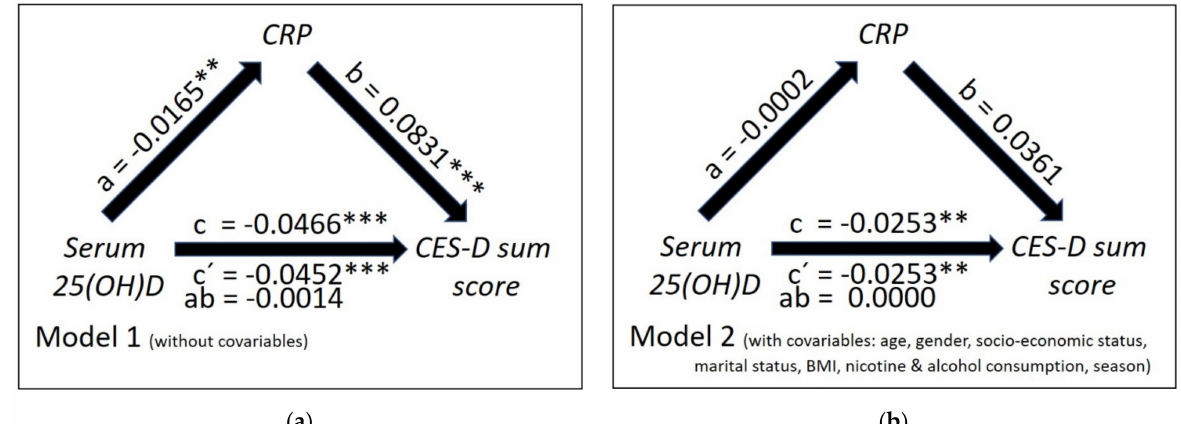
Figure 2. Mediation model without ( a ) and with covariates ( b ) showing both the total and direct effect of serum 25(OH)D concentrations on the intensity of depressive symptomatology as measured by CES-D sum scores (path coefficients c and c (cid:48) ) and the indirect effect of serum 25(OH)D concentrations on CES-D scores mediated through c-reactive protein (CRP) concentrations (path coefficient ab) in the study sample. The figures depict the unstandardized path coefficients (a,b,c,c (cid:48) and ab; with ** p < 0.010; *** p < 0.001).